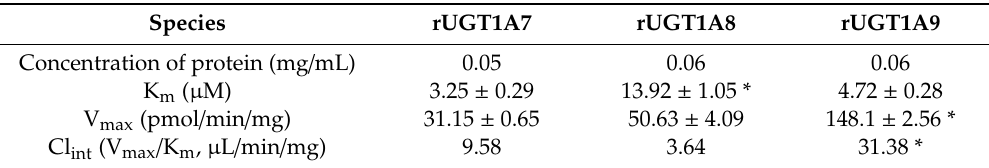
* p < 0.05 indicates a significant di ff